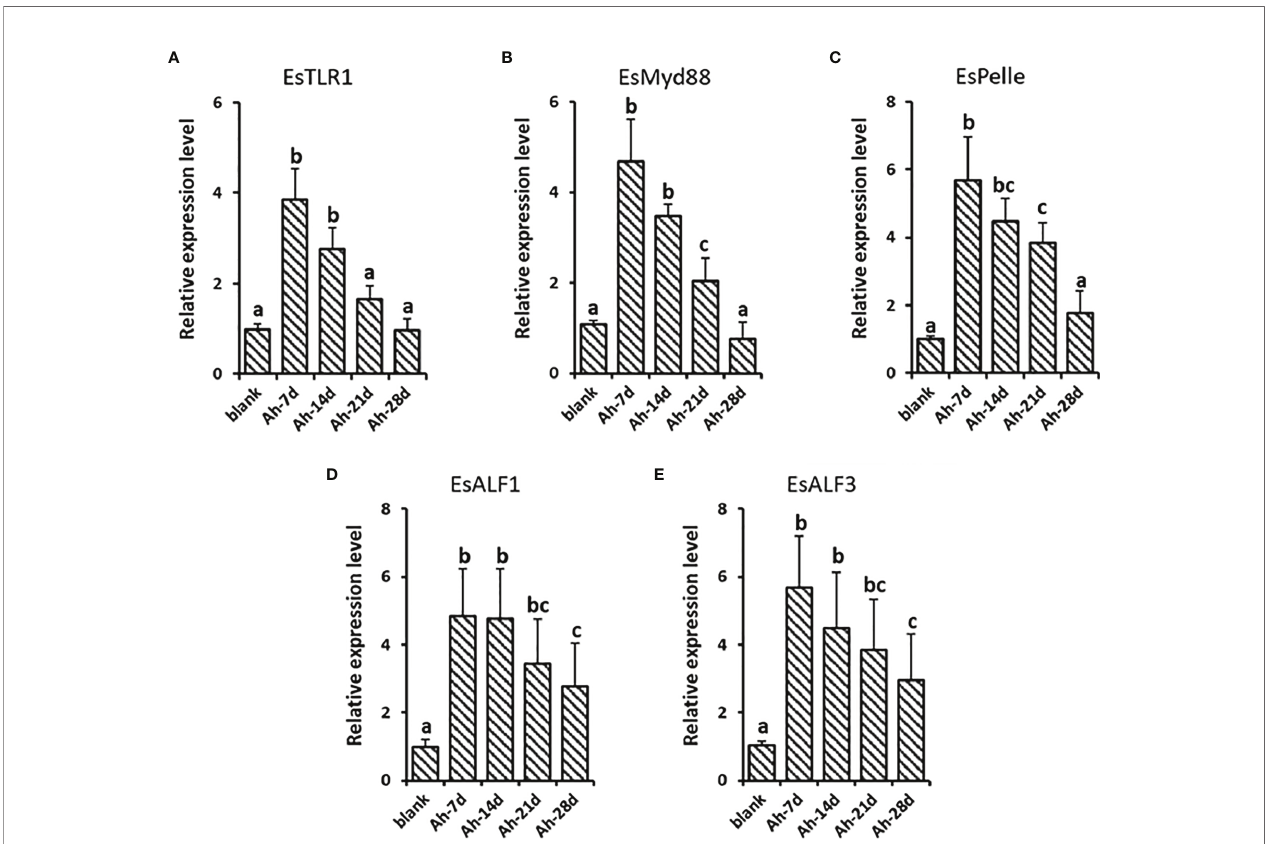
FIGURE 8 | The lastingly enhanced expression of ALFs in crab after priming stimulation. After A. hydrophila priming stimulation, the lasting expressions of Es TLR1 (A) , Es Myd88 (B) , Es Pelle (C) , Es ALF-1 (D) and Es ALF-3 (E) were detected at day 7 (Ah-7d), day 14 (Ah-14d), day 21 (Ah-21d) and day 28 (Ah-28d). Vertical bars represent the mean ± S. D. (N = 3), the letters (a, b, c) were used to present signi fi cant differences (p <